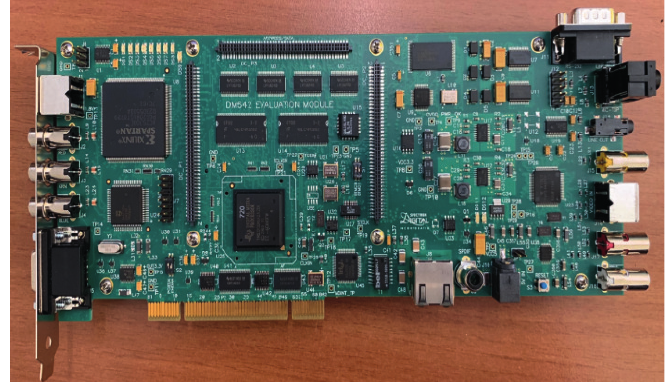
Figure 9. Board EVM